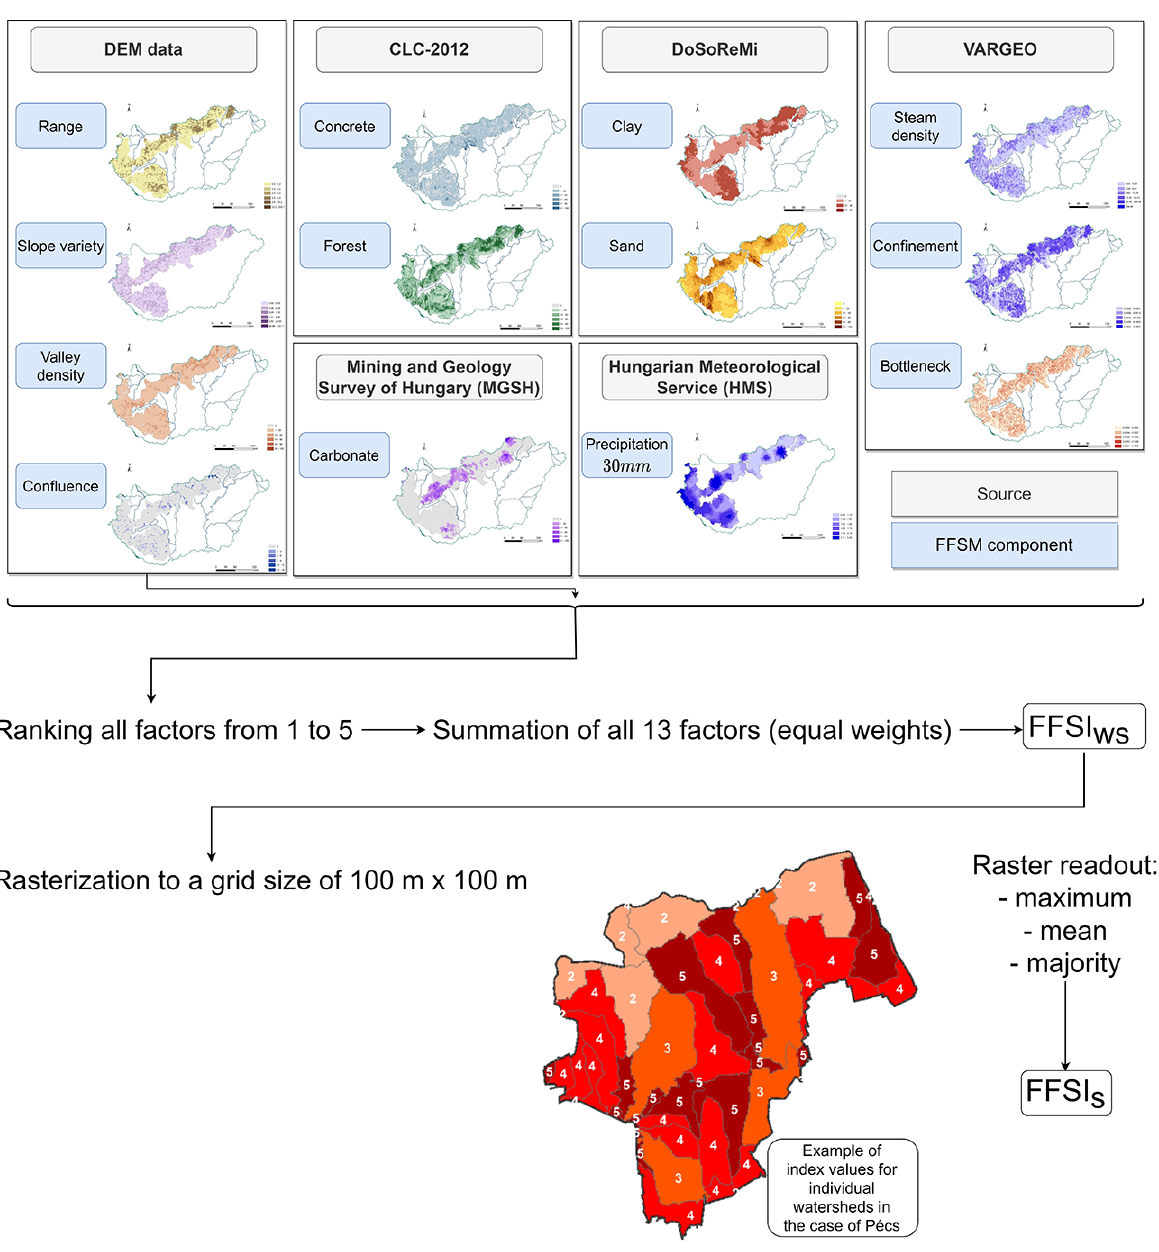
Figure 1. Flow chart visualization of the FFSIs